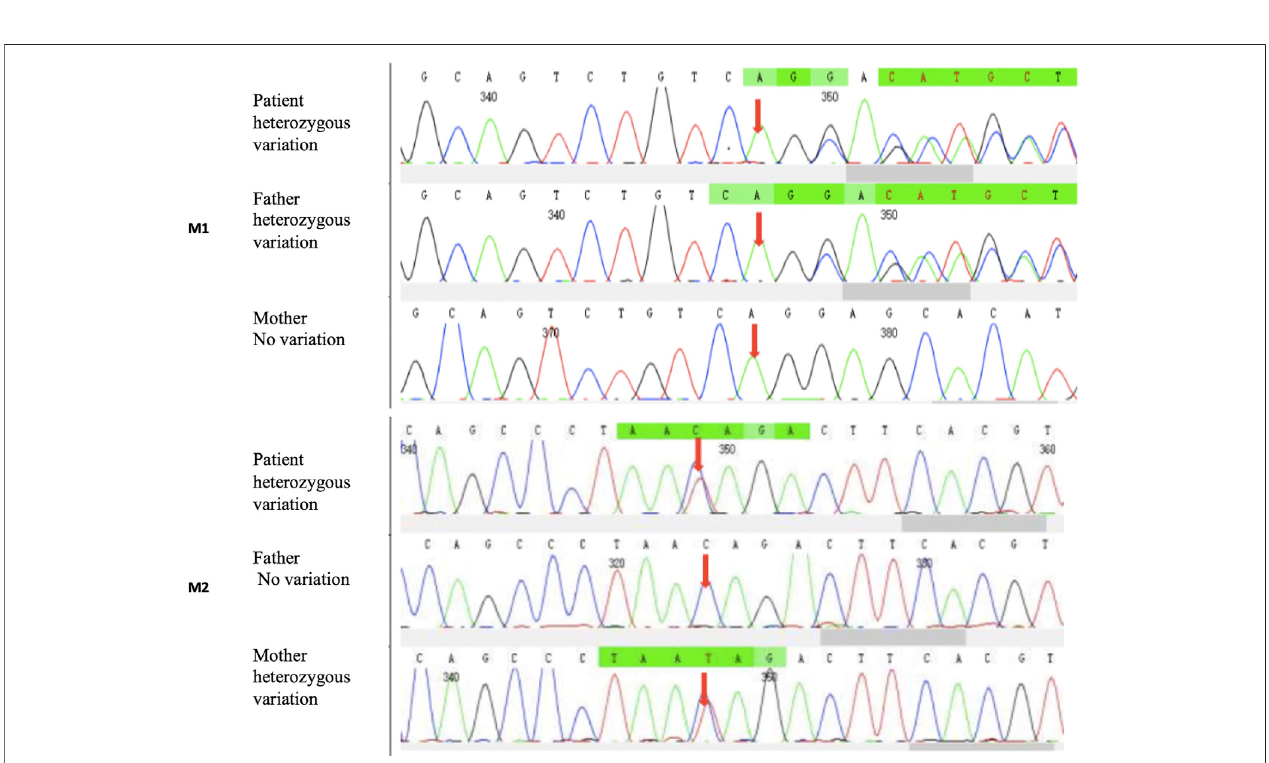
Frontiers in Genetics |